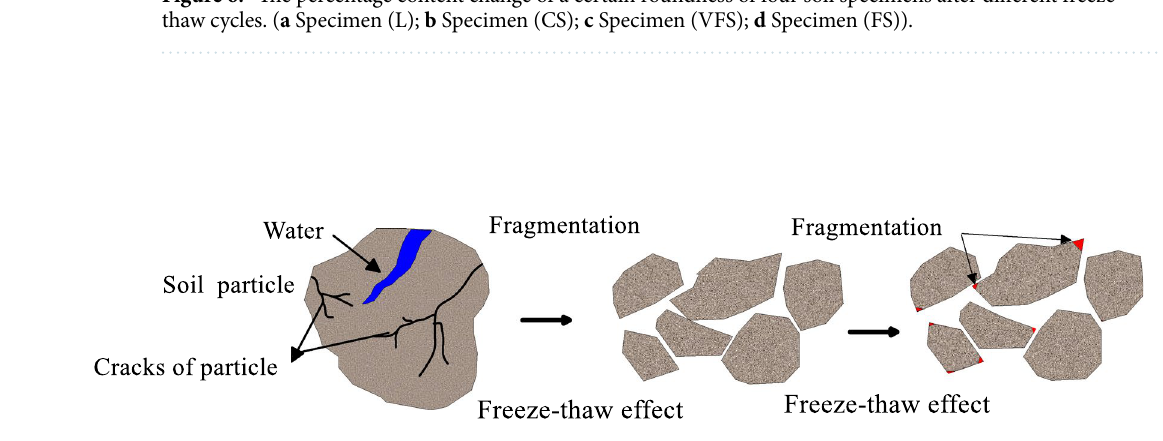
Figure 6. The percentage content change of a certain roundness of four soil specimens after different freeze– thaw cycles. ( a Specimen (L); b Specimen (CS); c Specimen (VFS); d Specimen (FS)).